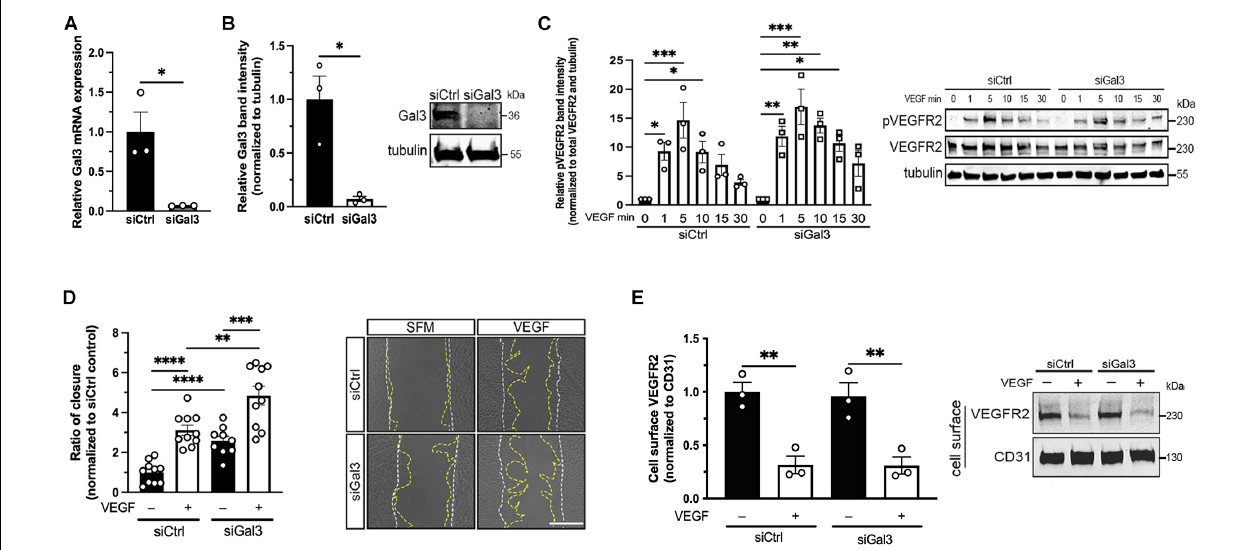
FIGURE 2 | Galectin-3 is not required for VEGF-induced VEGFR2 activity. (A) HRECs transfected with siRNA targeting Gal3 (siGal3) demonstrated over 90% mRNA knockdown of Gal3 compared to cells transfected with control siRNA (siCtrl), analyzed by reverse-transcription and qPCR assay. Student T -test was applied, ∗ P < 0.05, n = 3. (B) Lysate from HRECs transfected with siGal3 or siCtrl was analyzed by western blot and probed with an antibody against Gal3, which resulted in over 90% Gal3 protein reduction. Student T -test was applied, ∗ P < 0.05, n = 3. (C) siCtrl and siGal3 transfected HRECs were stimulated with 10 ng/ml of VEGF for 0, 1, 5, 10, 15, and 30 min. Cell lysates were collected and analyzed by western blot for tubulin, VEGFR2, and phospho-VEGFR2 (pVEGFR2 Y1175). Protein levels for pVEGFR2 were quantified using ImageJ and normalized to total VEGFR2 and α -tubulin. Ordinary one-way ANOVA was applied for comparisons within groups, ∗ P < 0.05, ∗∗ P < 0.01, ∗∗∗ P < 0.001, n = 3. (D) Confluent HRECs, transfected with siCtrl or siGal3, were scratched and stimulated with 10 ng/ml of VEGF. Images were taken immediately after scratching and 15 h later. Cell migration was quantified using ImageJ and normalized to the non-treatment control group. Scale bar represents 500 µ m. Student T -test was applied, ∗∗ P < 0.01, ∗∗∗ P < 0.001, ∗∗∗∗ P < 0.0001, n = 10. (E) HRECs transfected with siCtrl and siGal3 were stimulated with 10 ng/ml VEGF. Cell surface proteins were labeled with NHS-SS-biotin and isolated from cell lysate using avidin agarose beads. Total VEGFR2 and CD31 protein levels were analyzed by western blot. Student T -test was applied, ∗ P < 0.05, n =